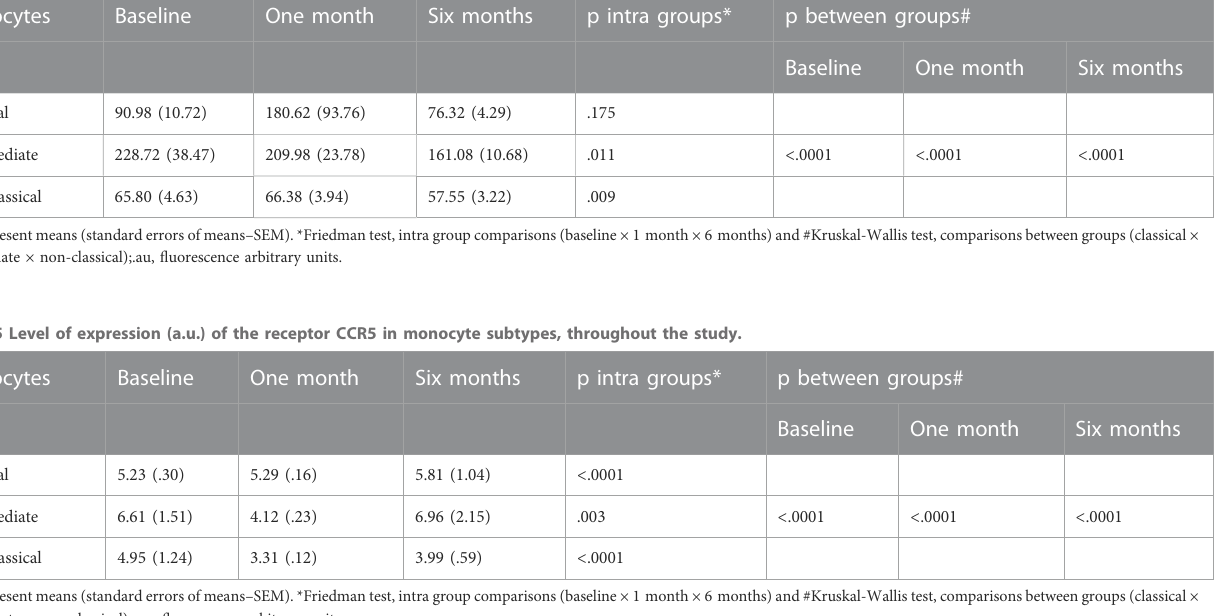
TABLE 4 Level of expression (a.u.) of the receptor CCR2 in monocyte subtypes, throughout the study. Monocytes